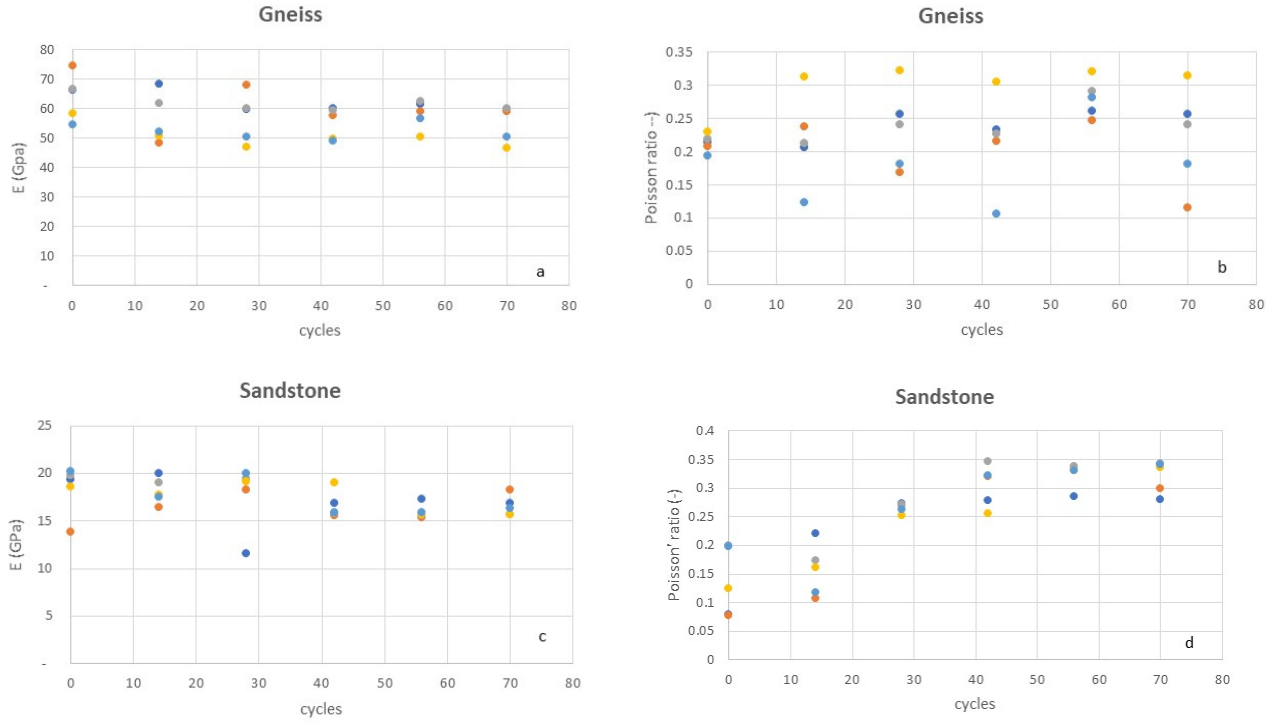
Figure 7. Evolution of dynamic Modulus ( a , c ) and Poisson’ ratio ( b , d ) calculated according to Equations (1) and (2) for gneiss ( a , b ) and sandstone ( c , d ) samples.